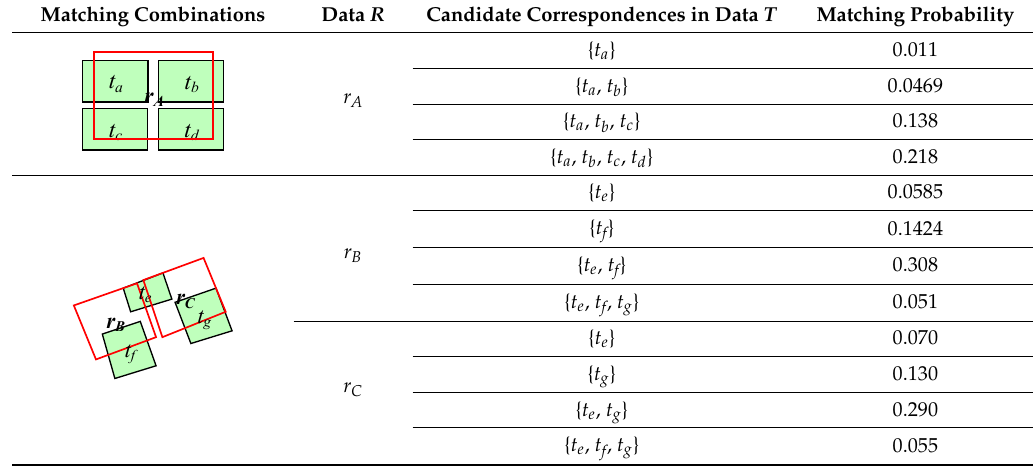
Table 3. Examples of candidate-matching pattern combinations. Table 3. Examples of candidate ‐ matching pattern combinations. Table 3. Examples of candidate ‐ matching pattern combinations. Table 3. Examples of candidate ‐ matching pattern